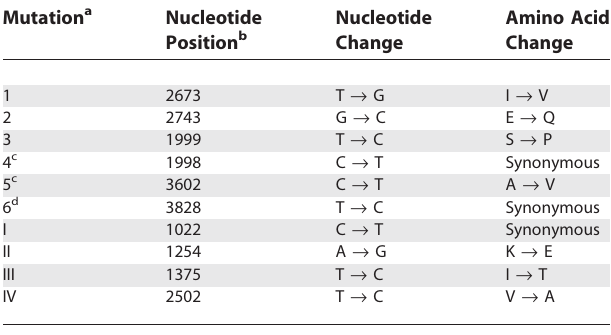
Table 1. Mutations Identified in the pag and cya Toxin Genes Mutation